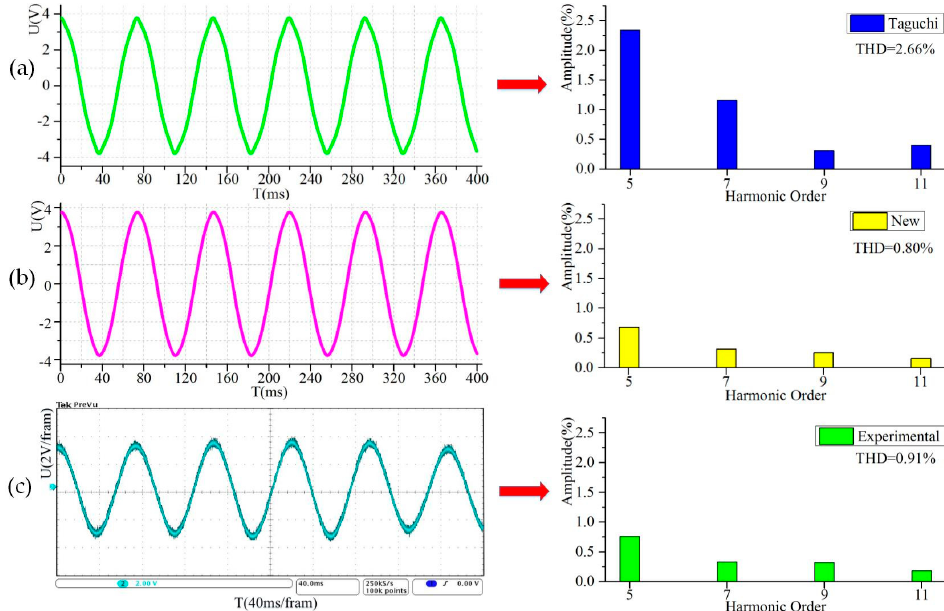
Figure 12. Inductive EMF and harmonic analysis by three methods: ( a ) Taguchi; ( b ) New; and ( c ) Experimental.